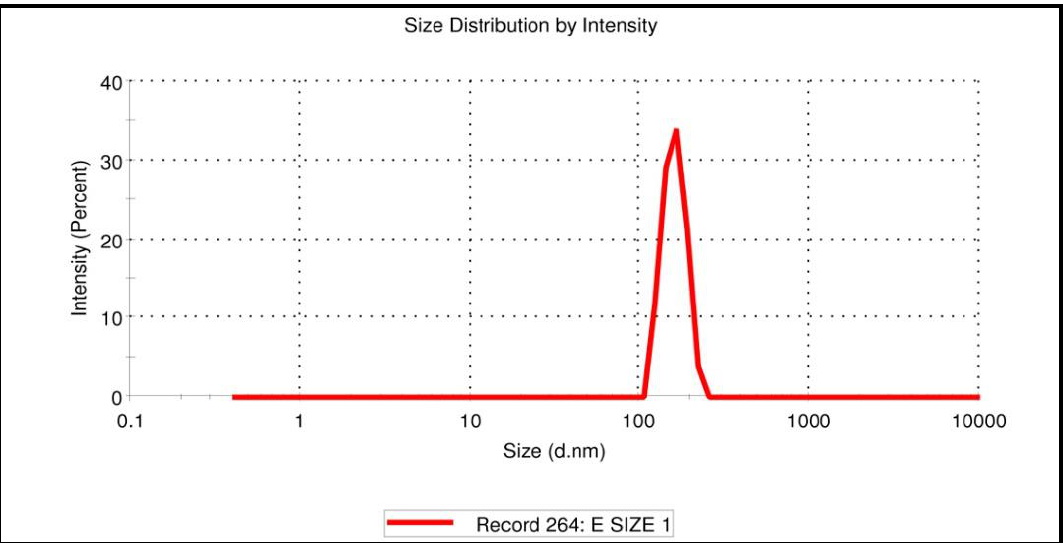
15 of 21 Figure 6. Fourier transform infrared spectroscopy (FTIR) of chitosan, thiolated chitosan, SGN, and SGN–TC nanoparticles. 3.9. Particle Size and Zeta Potential of SGN–TC Nanoparticles The particle size of SGN–TC nanoparticles (F3) was measured using laser light diffraction